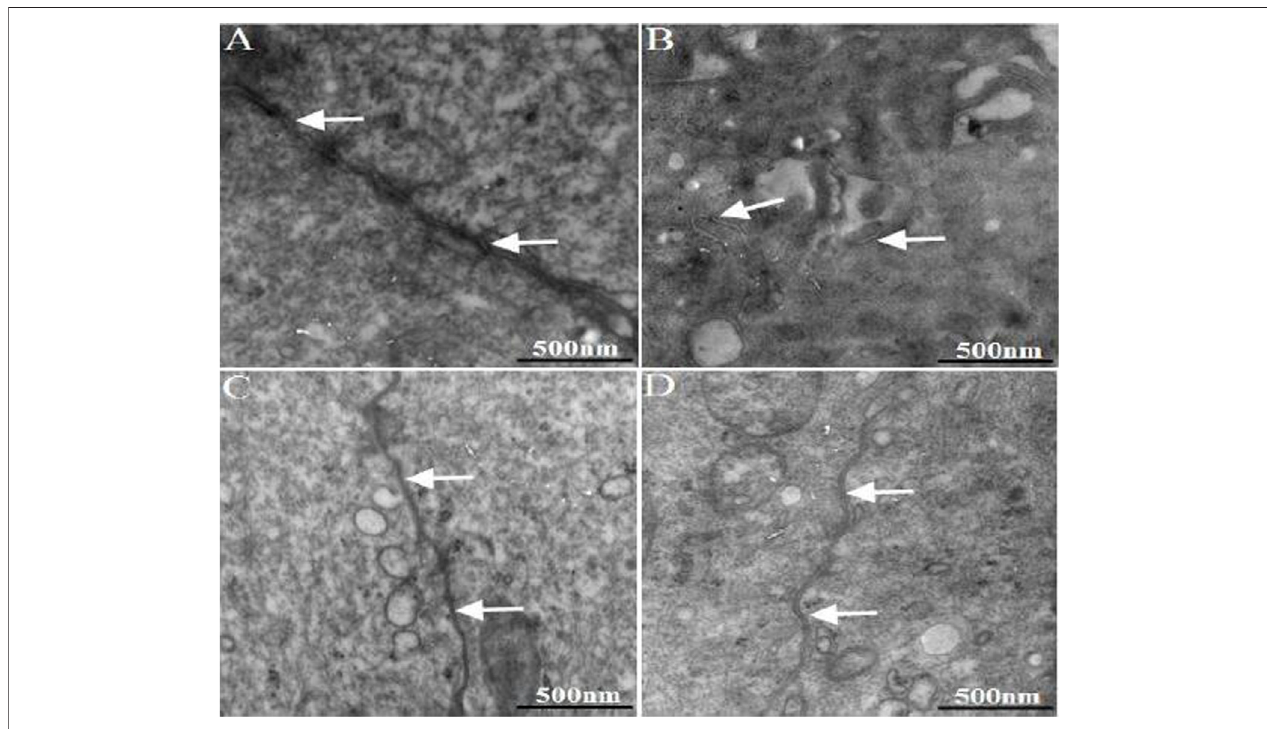
FIGURE 5 | The ultra-structure of TJ in the colonic epithelium of rats. The arrows indicated TJ [ (A) : normal; (B) model; (C) multiple dose of WJW in normal; (D) multiple dose of WJW in model].